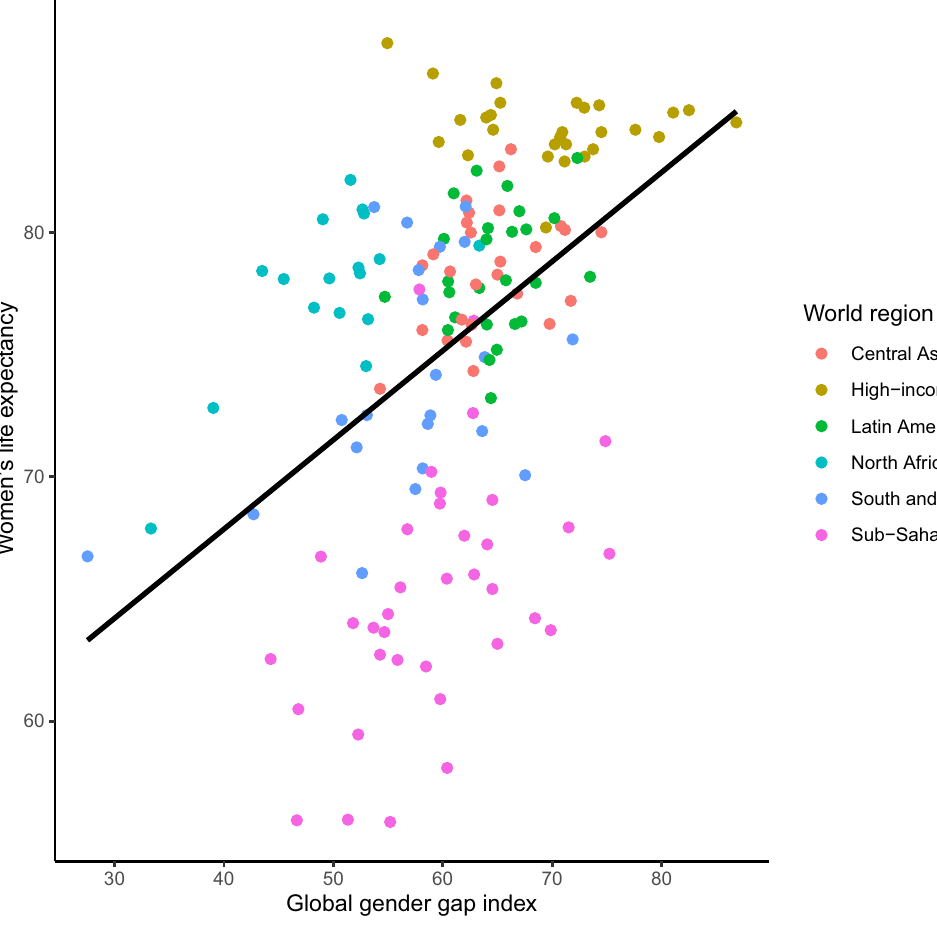
Fig 6. Cross-sectional association between the mGGGI and women’s life expectancy in 2020/1. The scatterplot displays the linear regression line for the association between the mGGGI and women’s life expectancy (3.65 [2.48 to 4.82], p-value < 0.001).